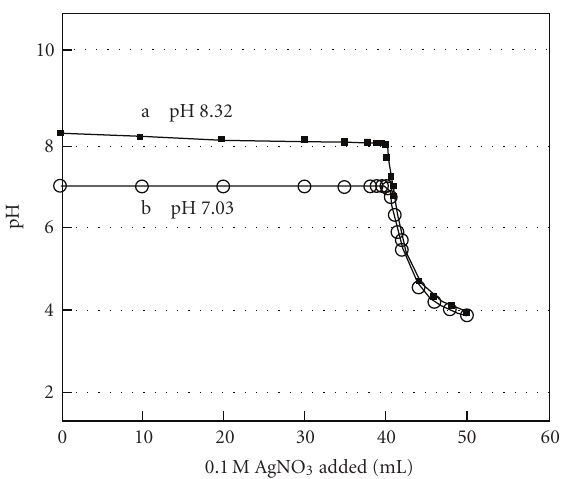
Table 4: Comparison of the Results of Determination of Chlorinity (g/kg) from the Mohr-Knudsen Method and the Present Methods with Phosphate/Phenolphthalein as Figure 4: Titration curves of 40.0mL of 0.1 M NaCl with a 0.1M AgNO 3 solution in the presence of 2.5mM Na 2 HPO 4 at two di ff erent initial pH values: (a) 8.32 ( ) and (b) 7.03 ( (cid:4) ). (cid:0)